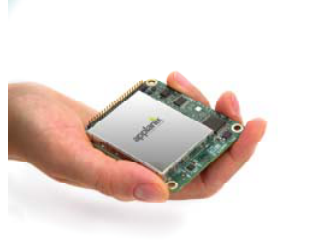
Figure 1: Applanix APX-15 UAV Single Board GNSS-Aided Inertial solution for Direct Georeferencing on